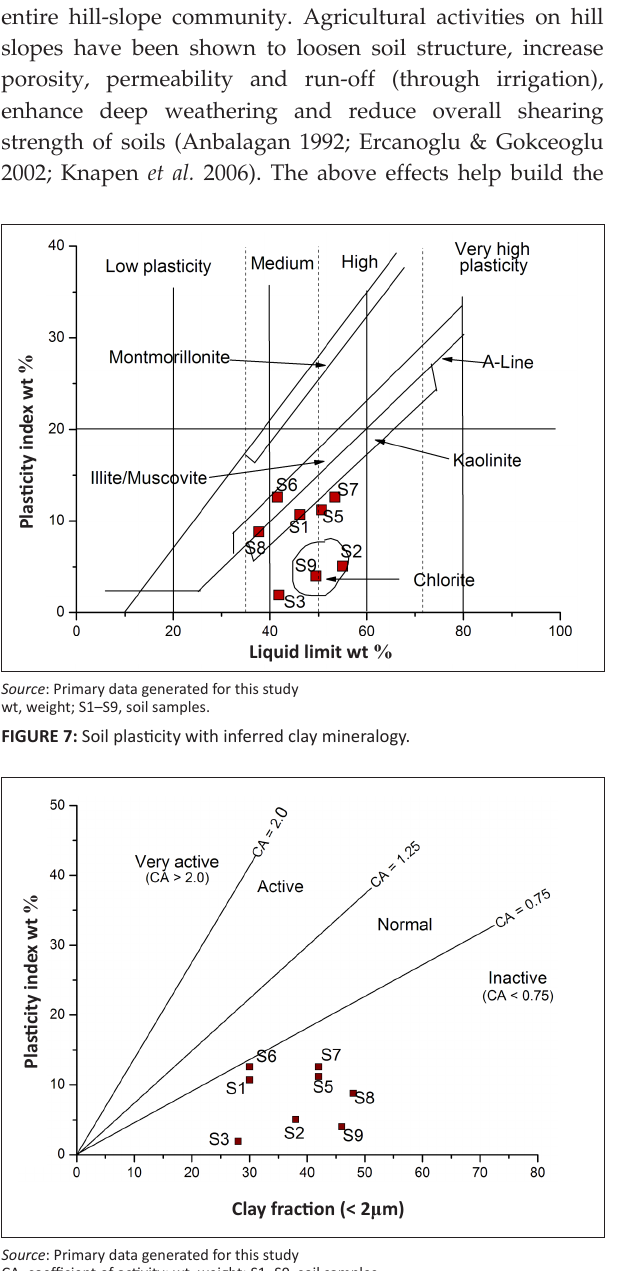
FIGURE 8: Activity diagram for soil samples from TABLE 2: Summary of clay mineral properties. Secondary mineral